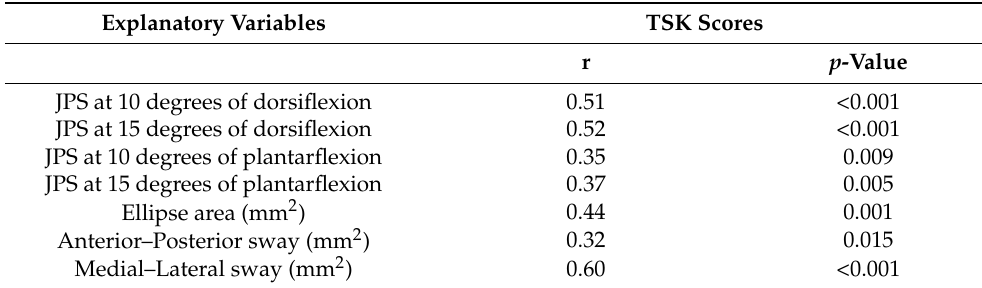
Table 2. Coefficient of correlation between TSK scores, joint position sense, and postural control ( n =